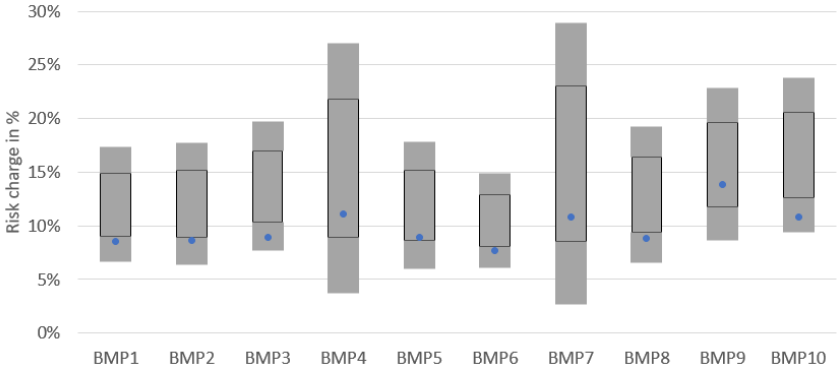
Figure 10. Comparison of the asset-only benchmark portfolios; representation based on own results (blue dot) and EIOPA (2021a, p. 16) (gray boxes).